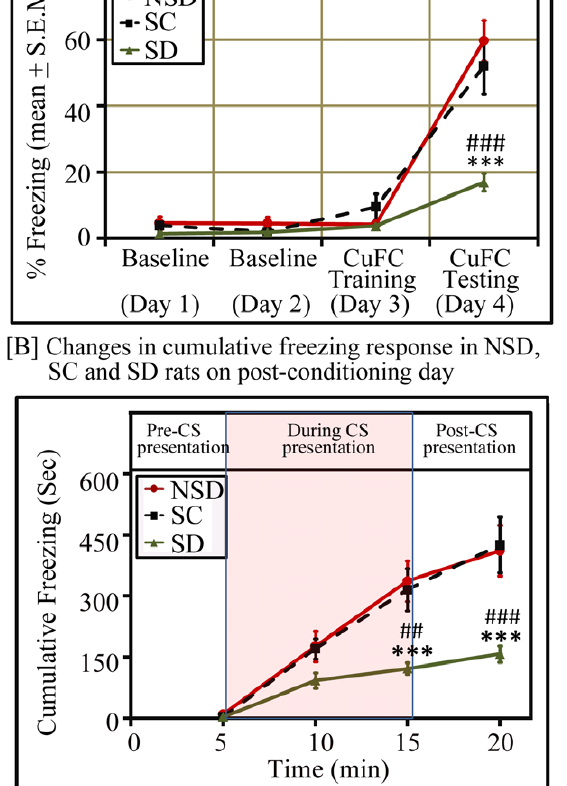
Figure 5. Percent and cumulative freezing responses in sleep- deprived (SD), non-sleep-deprived (NSD) and stress control (SC) rats. [A] On post-conditioning day, SD animals exhibited significantly less freezing compared to NSD and SC control animals (p , 0.001 compared to NSD group and SC group) (one-way ANOVA). [B] Changes in cumulative freezing response in SD, NSD and SC animals. NSD and SC groups demonstrated a sequential increase in freezing response during each 5 mins interval; however, SD animals exhibited significantly less freezing at the end of conditioned stimulus (CS) presentation (p , 0.001 compared to NSD animals; p , 0.01 compared to SC animals) and also during the post-CS presentation (p , 0.001 compared to both NSD and SC animals) (one-way ANOVA). Significance level: *** = p , 0.001 (compared to NSD group); ## = p , 0.01; ### = p , 0.001 (compared to SC